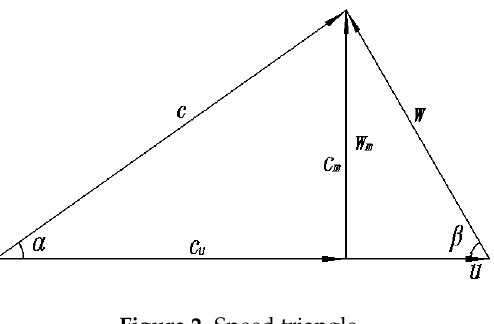
Figure 2. Speed triangle.